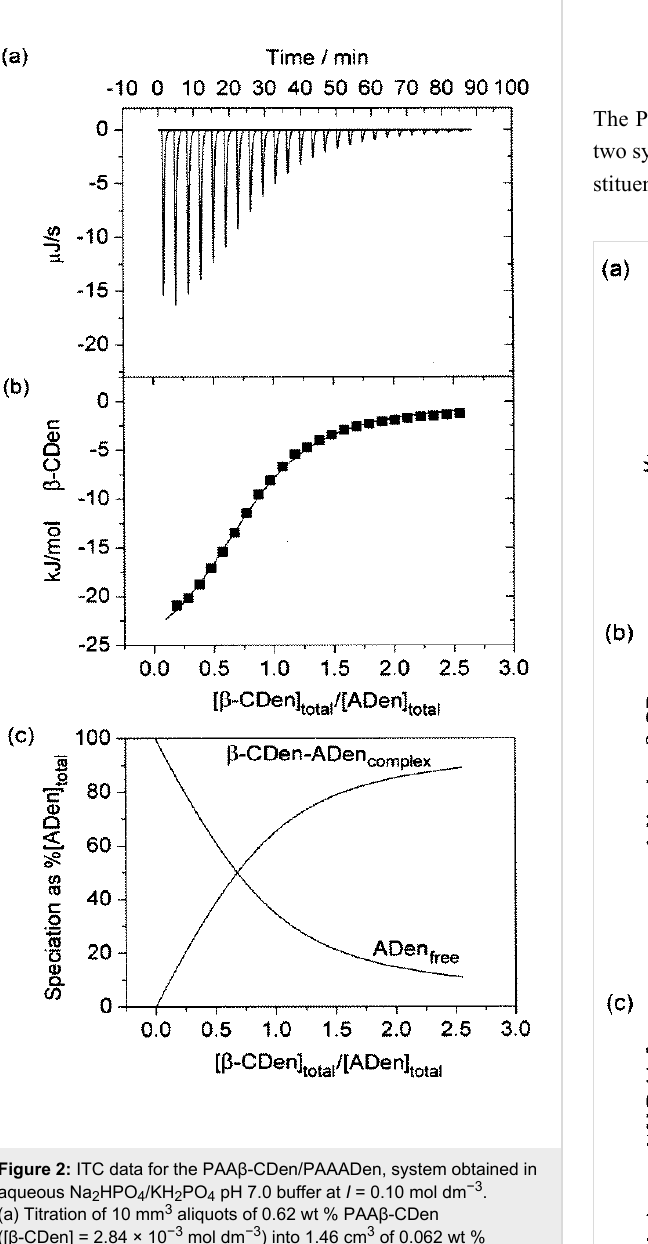
Figure 2: ITC data for the PAA β -CDen/PAAADen, system obtained in aqueous Na 2 HPO 4 /KH 2 PO 4 pH 7.0 buffer at I = 0.10 mol dm − 3 . (a) Titration of 10 mm 3 aliquots of 0.62 wt % PAA β -CDen ([ β -CDen] = 2.84 × 10 − 3 mol dm − 3 ) into 1.46 cm 3 of 0.062 wt % PAAADen ([ADen] = 2.06 × 10 − 4 mol dm − 3 ). (b) The solid curve shows the best fit of an algorithm for host–guest complexation between the β -CDen and ADen substituents to the titration data points. (c) Speciation plots showing for the variation of the [ β -CDen–ADen] complex and of the [ADen] free as percentage a of [ADen] total = 100%. This is attributed to either steric hindrance by the poly(acrylate) backbone, or hydrophobic association of the adamantyl substit- uents, or both, hindering complexation.